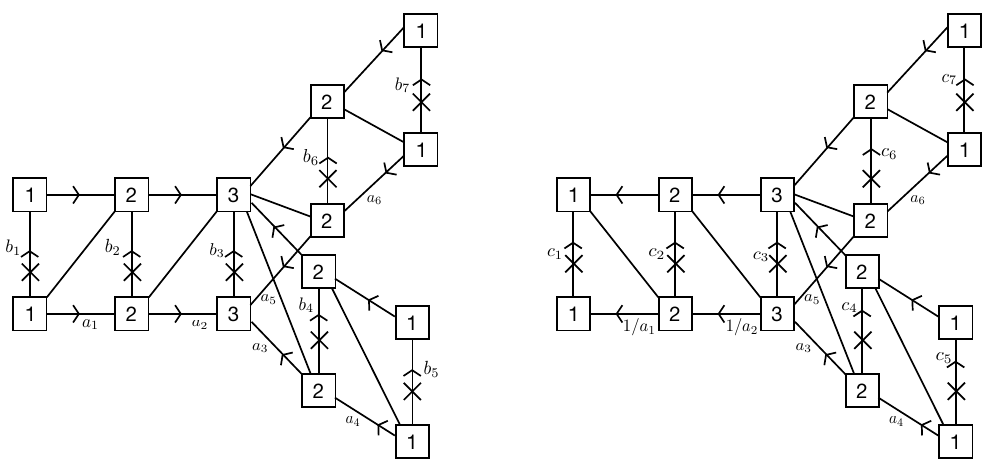
Figure 14 . Basic domain walls in the a(cid:14)ne E 6 quiver theory with D 1 = f + 6 g (cid:12) and D 2 = f(cid:0) ; (cid:0) ; + 4 g (cid:12) , respectively. The integer numbers l i in the boxes denote the SU( l i N ) gauge symmetries at the